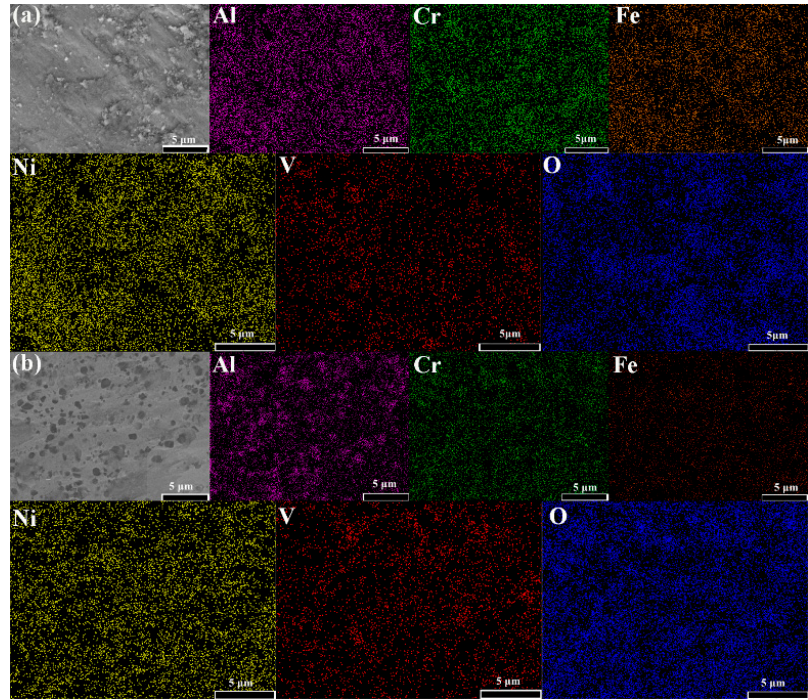
Figure 8. The worn surface SEM image and corresponding EDX mapping of ( a ) HEA dry wear and ( b ) HEA with lubrication.